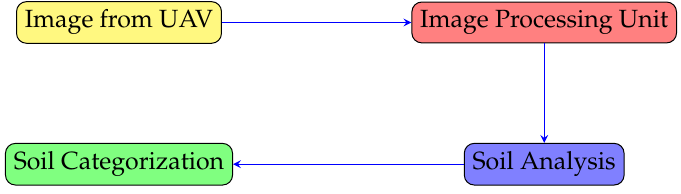
Figure 5. Decision on soil